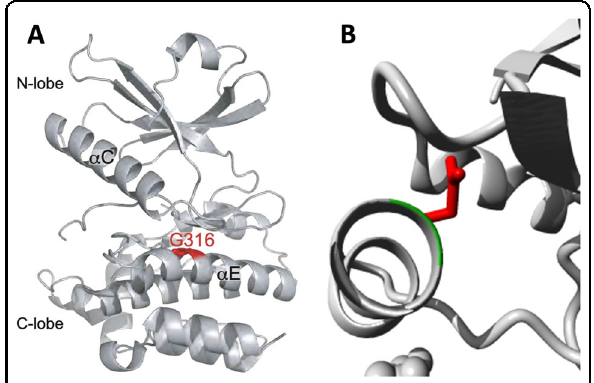
Fig. 2 MLKL G316D mutation is predicted to affect the pseudokinase domain structure (PDB accession 4MWI) 38 . ( A ) The substitution is in the α E helix within the C-lobe. ( B ) A close up of the amino acid change showing the wild type residue in green and the mutant aspartic acid side chain in red. Figures drawn with Pymol (Schrodinger, LLC. 2010) and HOPE 58